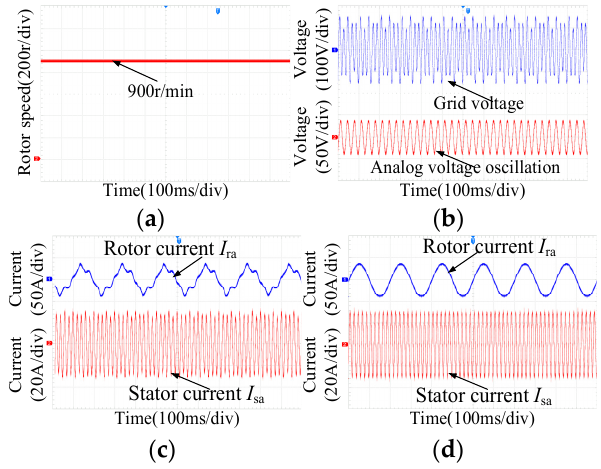
Figure 17. The oscillation suppression suppressed-contrast waveforms at SSO frequency of 30 Hz: ( a ) DFIG rotor speed; ( b ) grid voltage oscillation waveform; ( c ) before oscillation suppression; ( d ) after oscillation suppression.